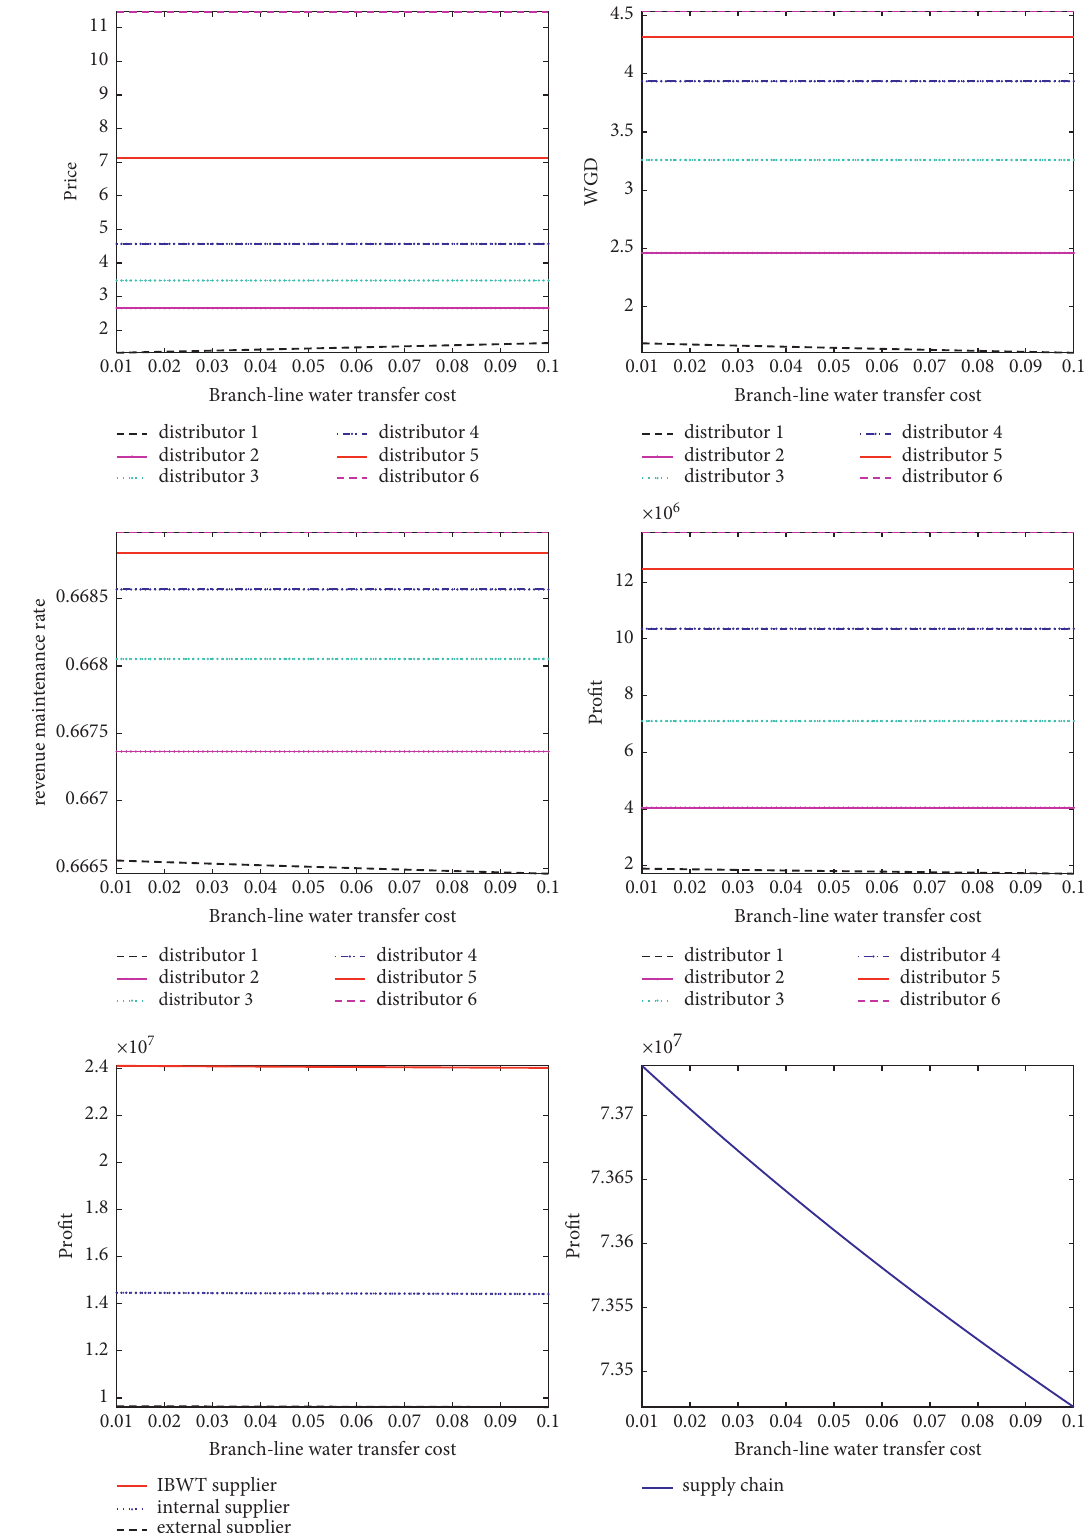
Figure 6: Sensitivity analysis of branch-line water transfer cost